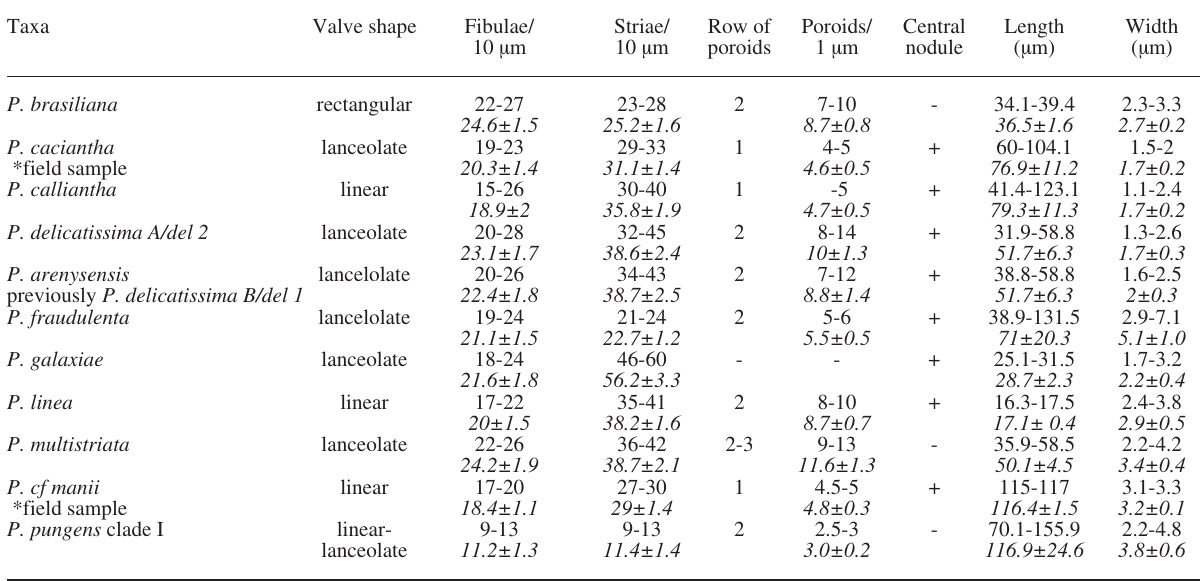
Table 4. – Morphometric data of Pseudo-nitzschia of the NW Mediterranean Sea from the present study (clonal culture and *field samples). Numbers in italics are the mean and standard errors of the measures taken in SEM (n=10 cells per sample).